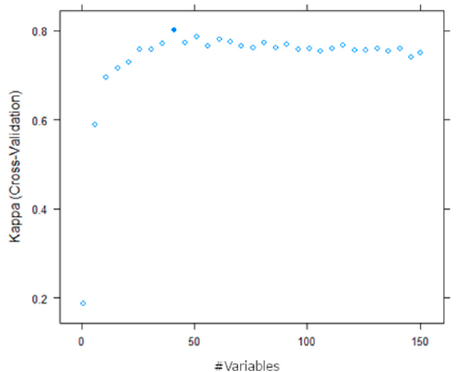
Figure 11. Classification model generated using SVMs as classifier and by applying a recursive feature selection process (scenario 3), which maximized the accuracies on the validation set as shown in Table 7. The plot reports the Kappa statistic obtained in cross-validation in function of the number of variables/features used to build the model. A number of features equal to 41 maximized the Kappa statistic, which is highlighted with the filled circle.